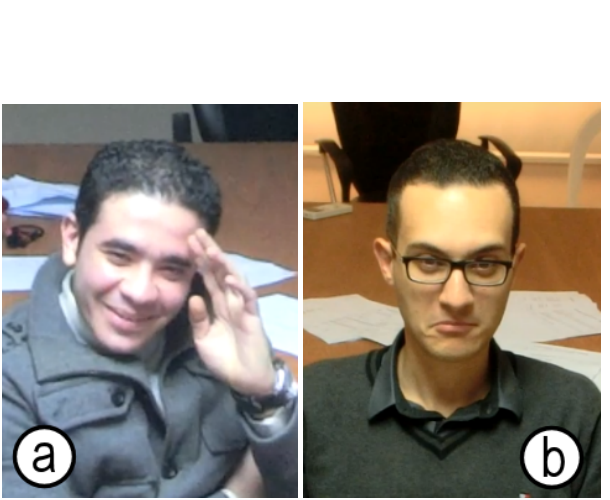
Figure 7. Example of some positive non-verbal cues (a) and of some negative ones (b) for Egyptian